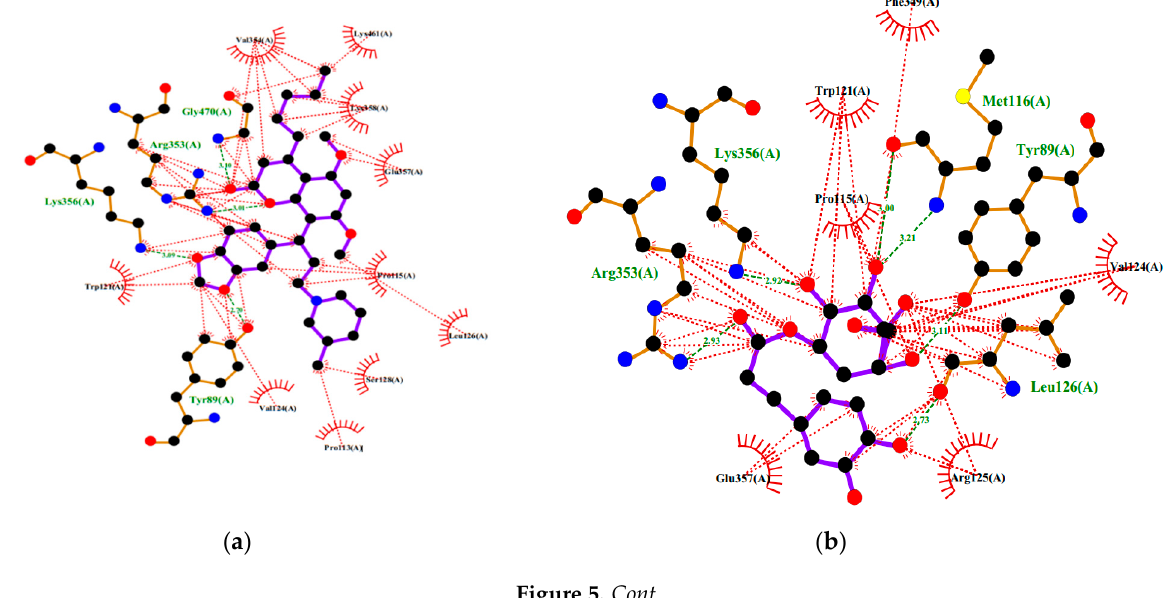
To determine the IC 50 value of each sample, a regression curve of the extract concentra- tion-DENV-2 inhibition percentage was made using graph pad prism 8.4.3. The antiviral activity of the synthesized silver nanoparticles and crude extract of C. papaya leaves tested against DENV-2 indicated that the C. papaya methanol leaf extract silver synthesized nanoparticles were the most promising, with an IC 50 of 9.20 µ g/mL (Table 3 and Figure